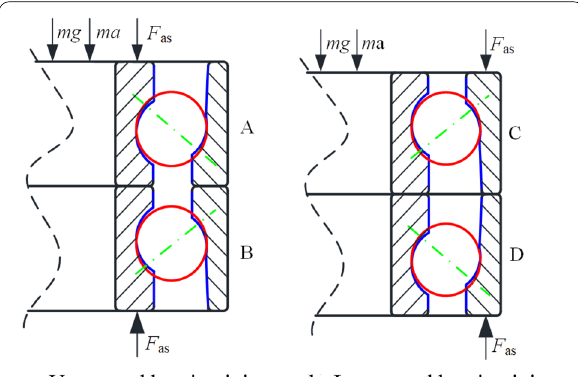
Figure 5 Force diagram of bearing joints under upward